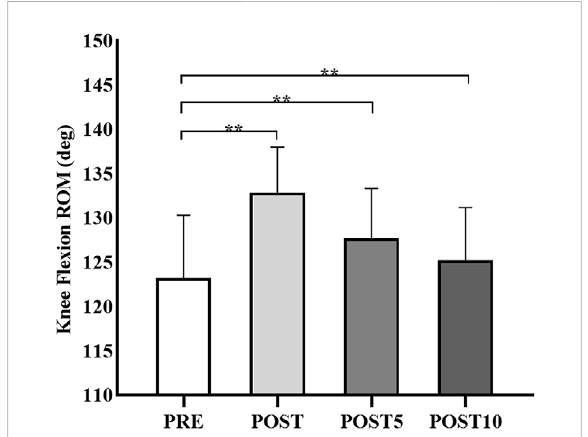
FIGURE 2 Knee fl exion range of motion (ROM) changes before (PRE) andimmediatelyafterstaticstretching(POST),or5(POST5)and10 (POST 10) min after static stretching. pp p <